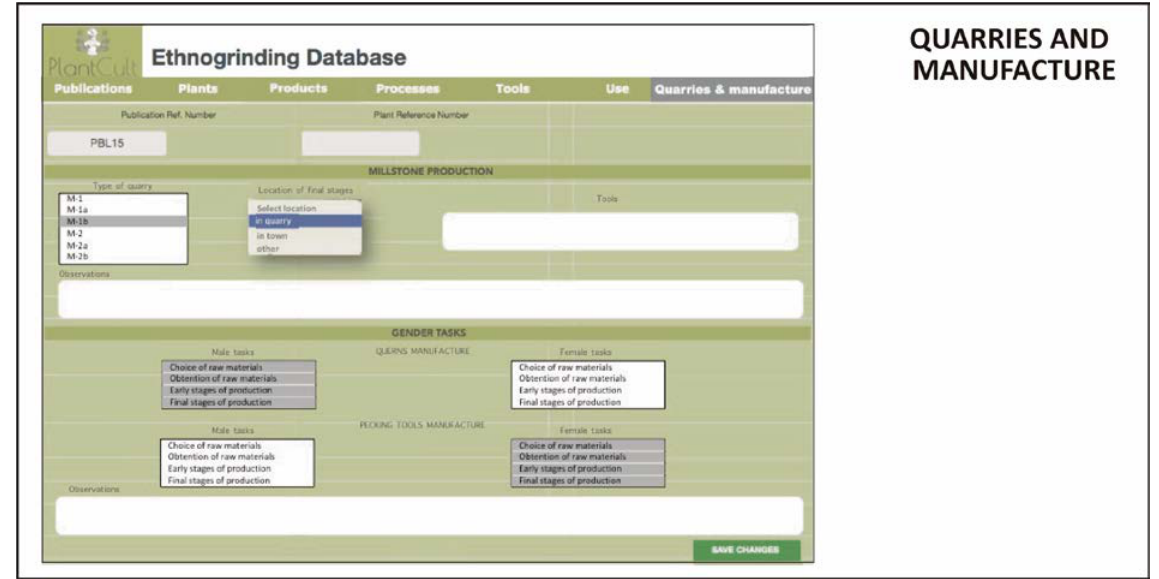
Figure 9. The Quarries and Manufacture